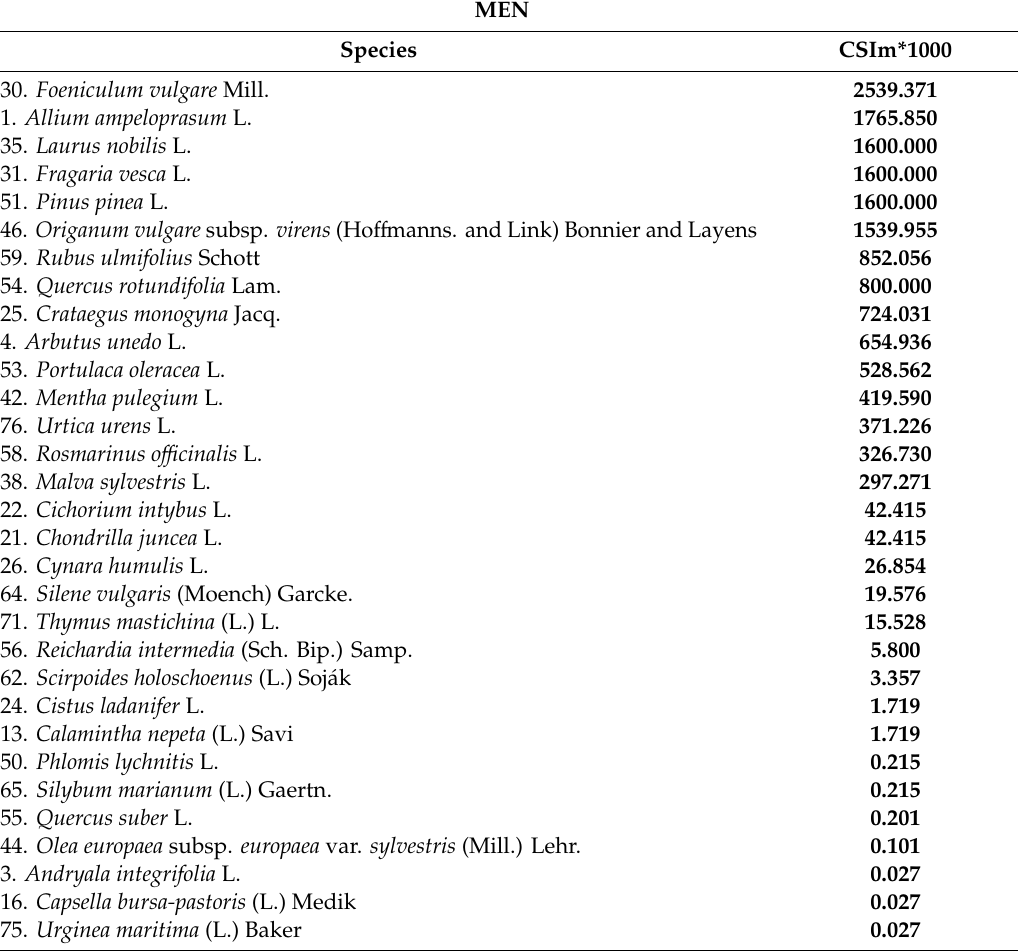
Table 4. List of taxa with the greatest importance for men ordered from highest to lowest value for